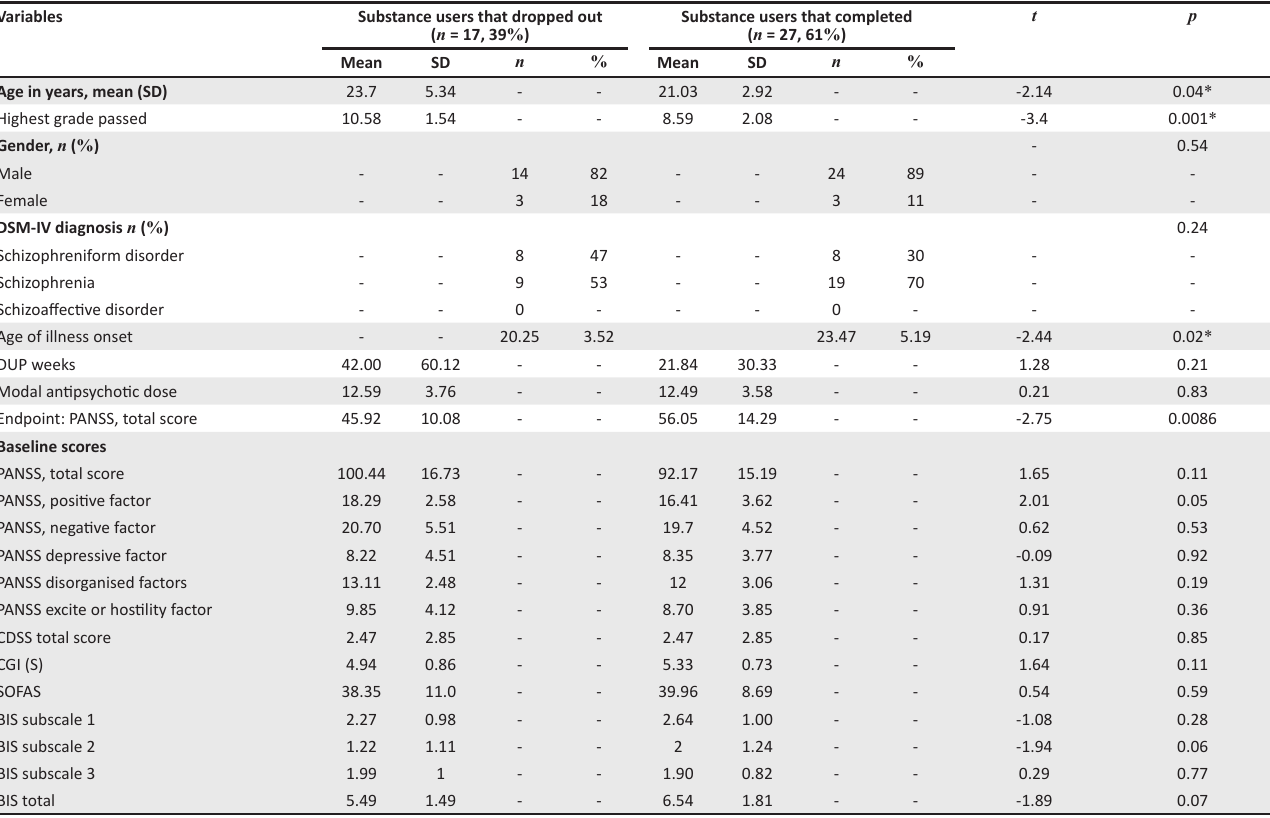
TABLE 2: Demographic and clinical scores for dual diagnosis (first episode of schizophrenia and substance use disorders) participants who dropped out compared to those who completed 24 months of treatment. Variables